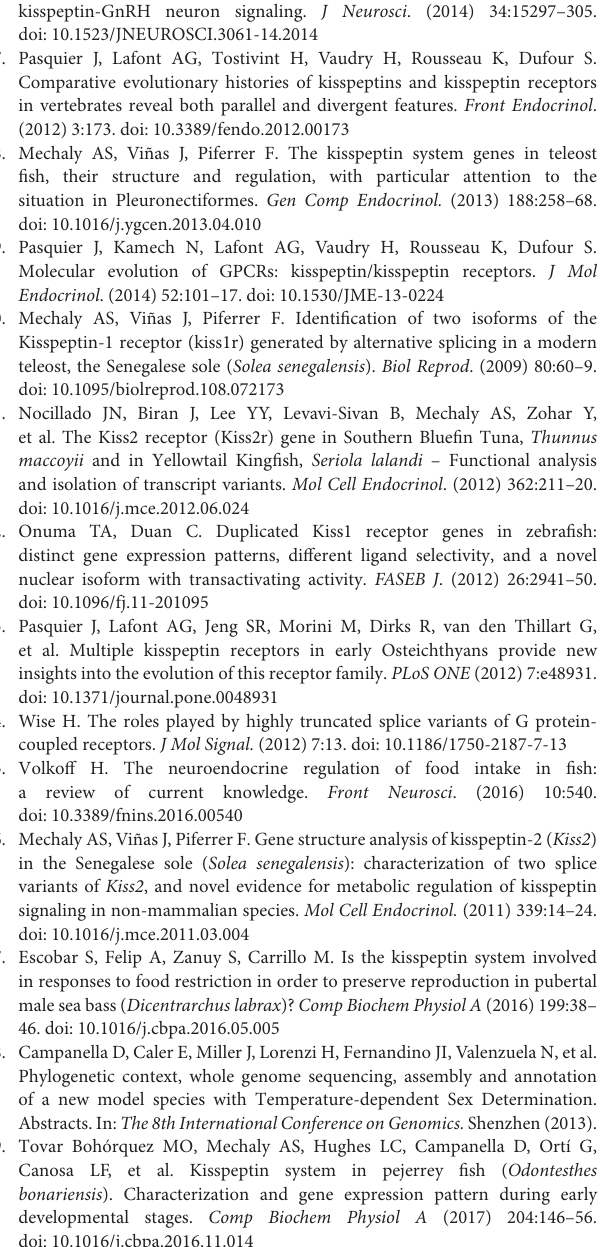
Supplementary Figure 5 | Summary of alternative splicing due to intron retention and exon deletion detected in kissr3 gene of teleost